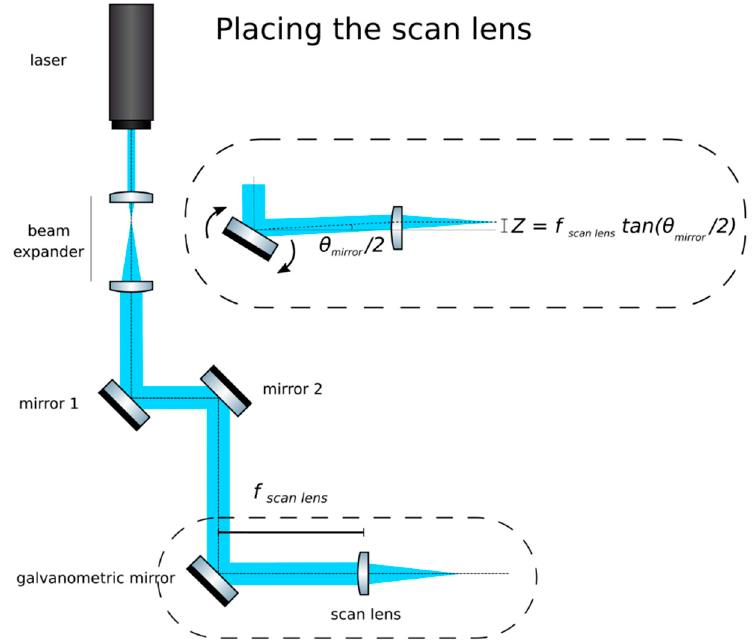
Figure 4. The scan lens should be one focal distance away from the galvanometric mirror. If placed correctly, rotations of the mirror will produce displacements but not rotations of the beam.